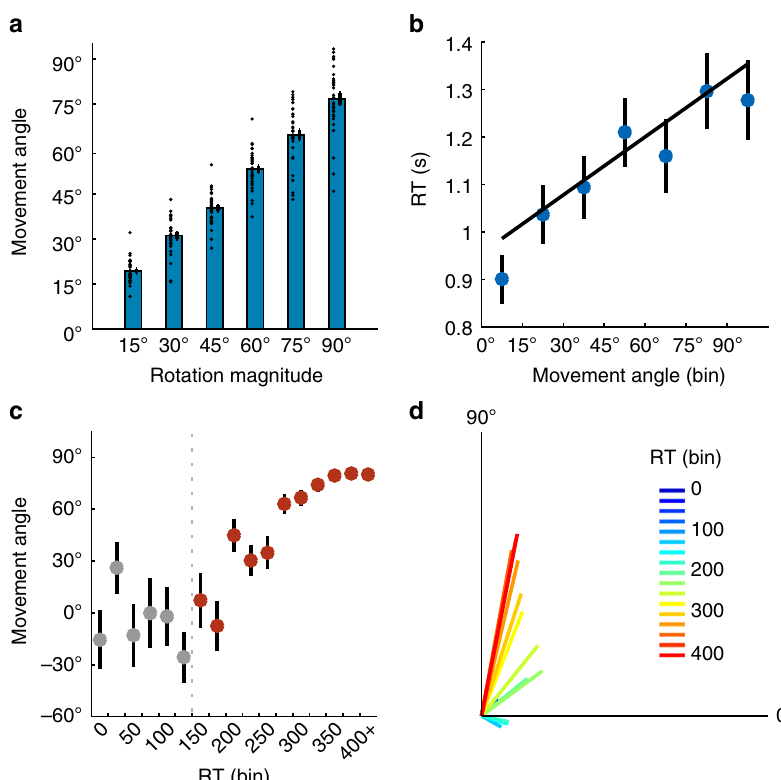
Fig. 4 Experiment 2 results. a Absolute movement angles as a function of absolute rotation magnitude in the FREE task ( n = 32). b Mean of median RTs as a function of movement angle (binned by 15 ˚ ). c Circular mean of movement angles as a function of RT (binned in 25 ms bins) in the FORCED task ( n = 32). Gray dots represent RT bins where movements were deemed as primarily random (see Methods). d Pooled vector representation of data in c , where colors represent the associated RT bin (in ms). Error bars represent 1